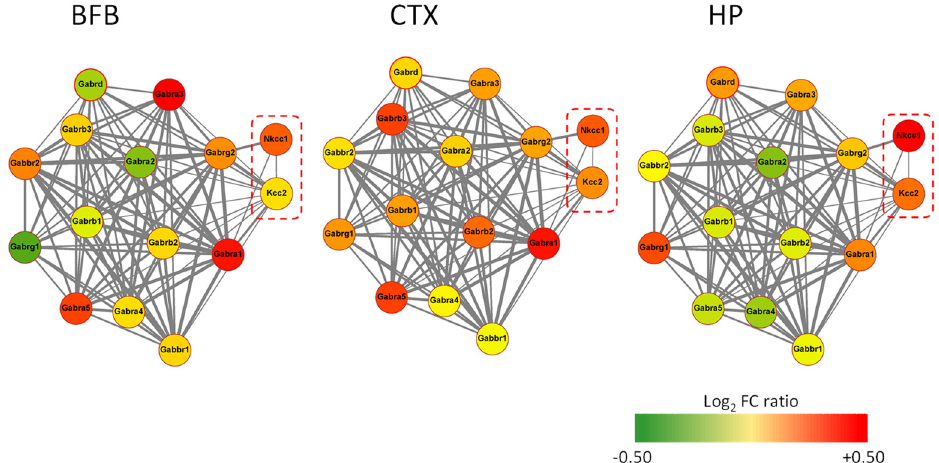
Figure 3. Interaction network in AD11 mice for NKCC1, KCC2, GABA A , and GABA B receptor genes. Interaction network extracted from the STRING database (https://string-db.org/, high interaction confidence level) for the NKCC1, KCC2 cation-chloride co-transporter genes (encircled in red), and the GABA A , GABA B receptor channel subunits genes in mouse. The node color corresponds to the Log2-fold change-relative expression ratio in 6-month-old AD11 mouse compared to control mouse in three brain areas (basal forebrain, BFB; cortex, CTX; and hippocampus, HP). The thickness of grey edges between nodes corresponds to the interaction reliability provided by